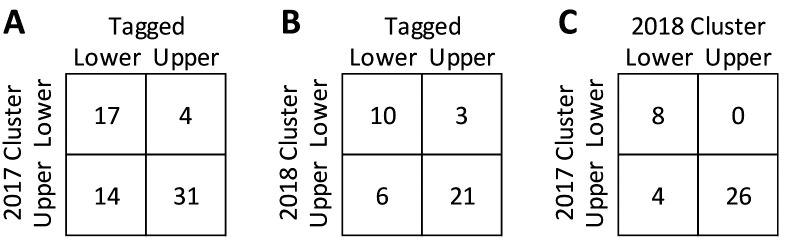
Cross-classification of regions at tagging and as determined by 2017 and 2018 clustering of spawning run contingents.(A) 2017 spawning run centroids v. 2016 tagging locations; (B) 2018 spawning run centroids v. 2016 tagging locations; (C) 2017 spawning run centroids v. 2018 spawning run centroids.